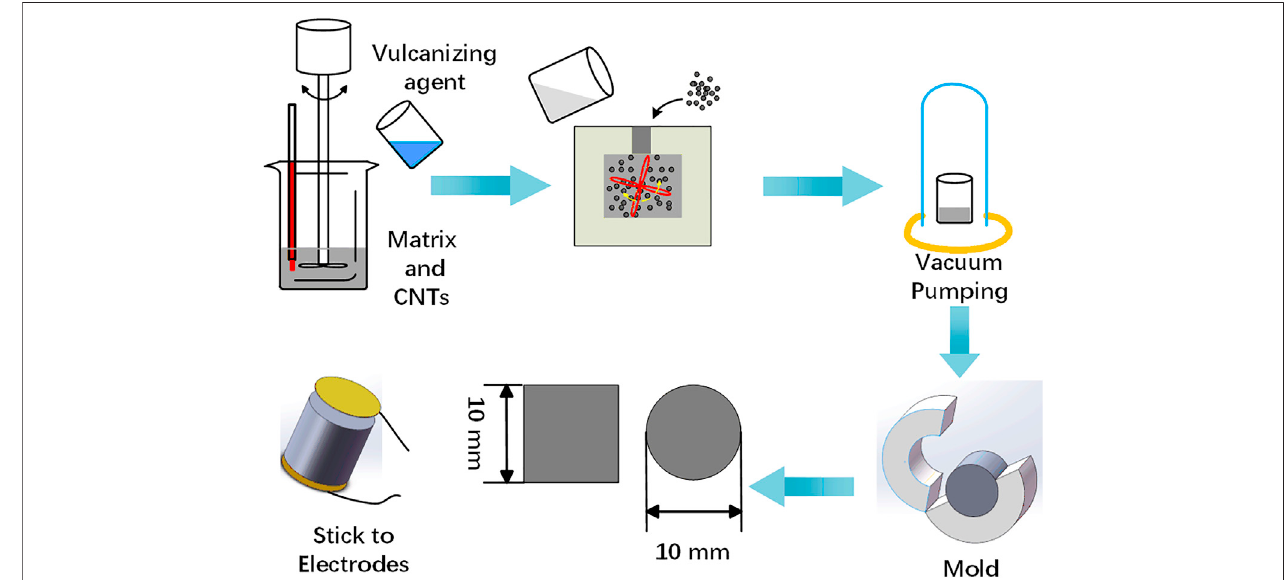
FIGURE 1 | Schematic of the material